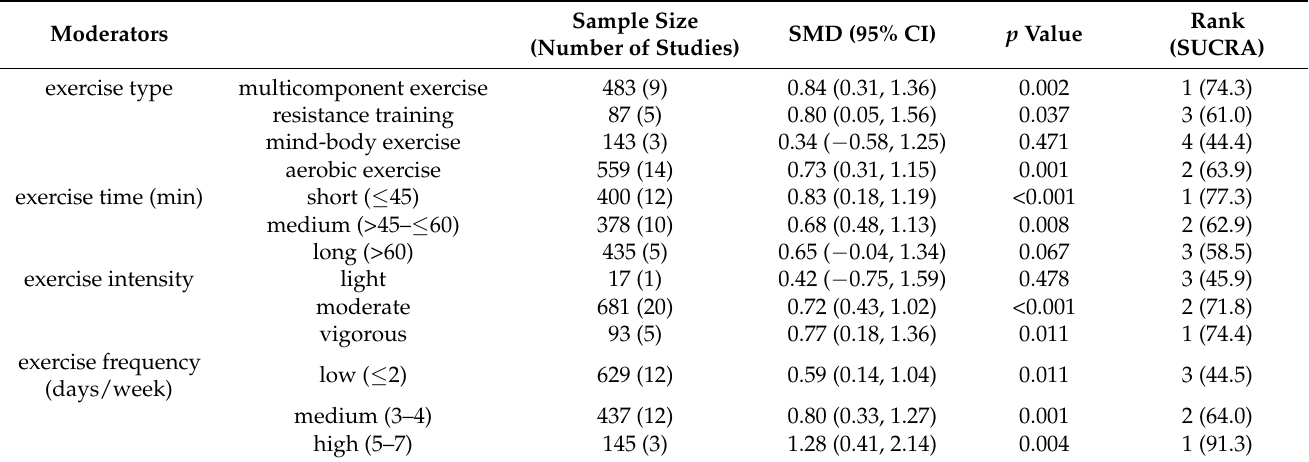
Table 4. Results of the NMA and